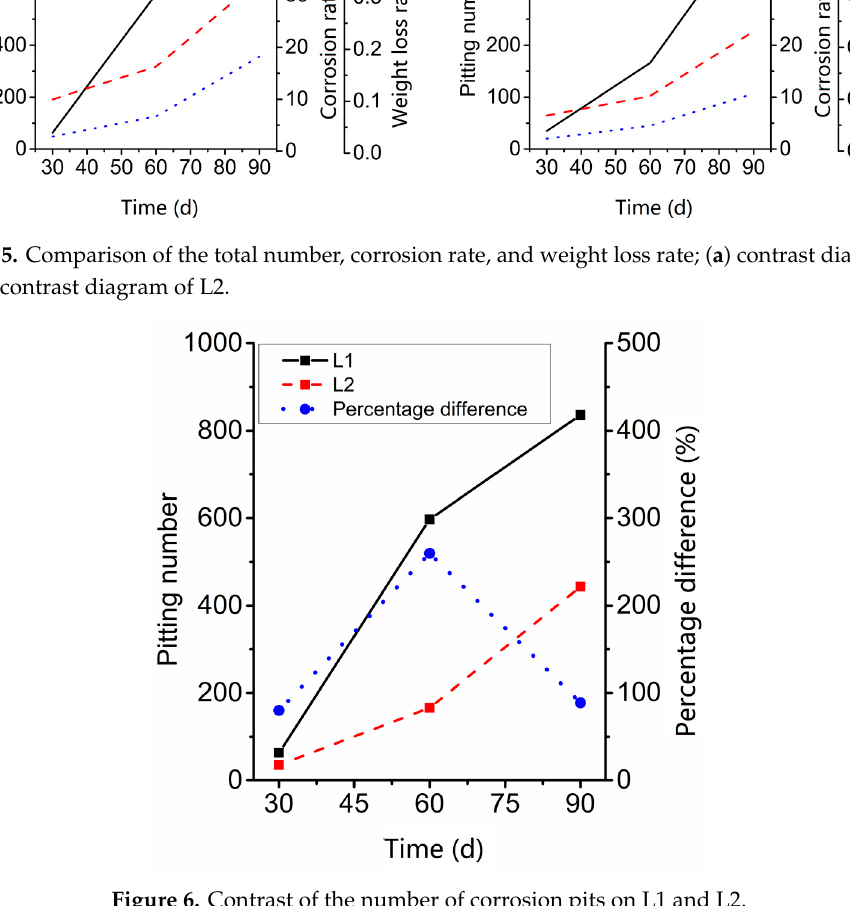
Figure 6. Contrast of the number of corrosion pits on L1 and L2.